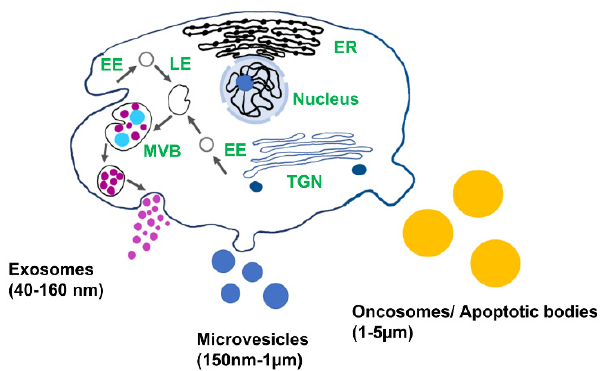
Figure 1. Schematic of different types of extracellular vesicles and their biogenesis: EE: early endosomes, LE: late endosomes, MVB: multivesicular body, TGN: trans-Golgi network, and ER: endoplasmic reticulum.